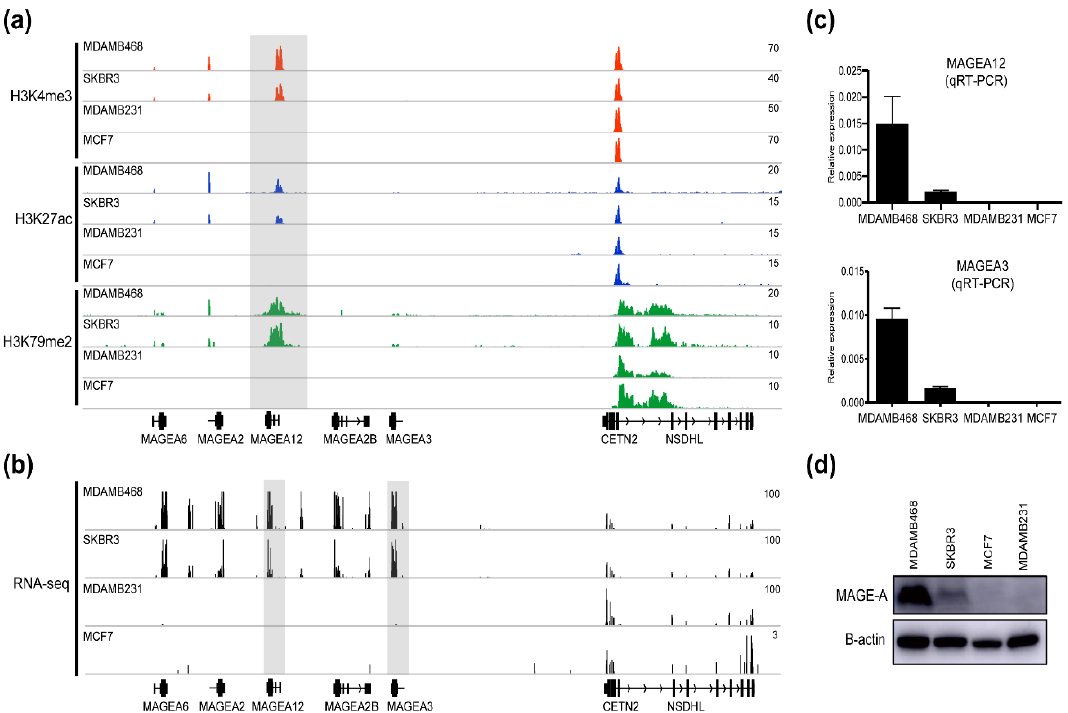
Figure 2. Histone modifications at the MAGEA12 locus in four breast cancer cell lines that have high or low MAGEA12 and MAGEA3 expression. ( a ) IGV genome browser snapshot showing the ChIP-seq data for H3K4me3, H3K27ac, and H3K79me2 in the MAGEA12 high-expressing (MDAMB468; TNBC and SKBR3; HER2+) and low-expressing (MDAMB231; TNBC and MCF7; Luminal) cell lines. ( b ) Snapshot of RNA-seq reads at the MAGEA12-associated loci in the four cell lines. ( c ) qRT-PCR expression of MAGEA12 and MAGEA3 in the four cell lines. ( d ) Western blot analysis of MAGE-A proteins in the four cell lines.